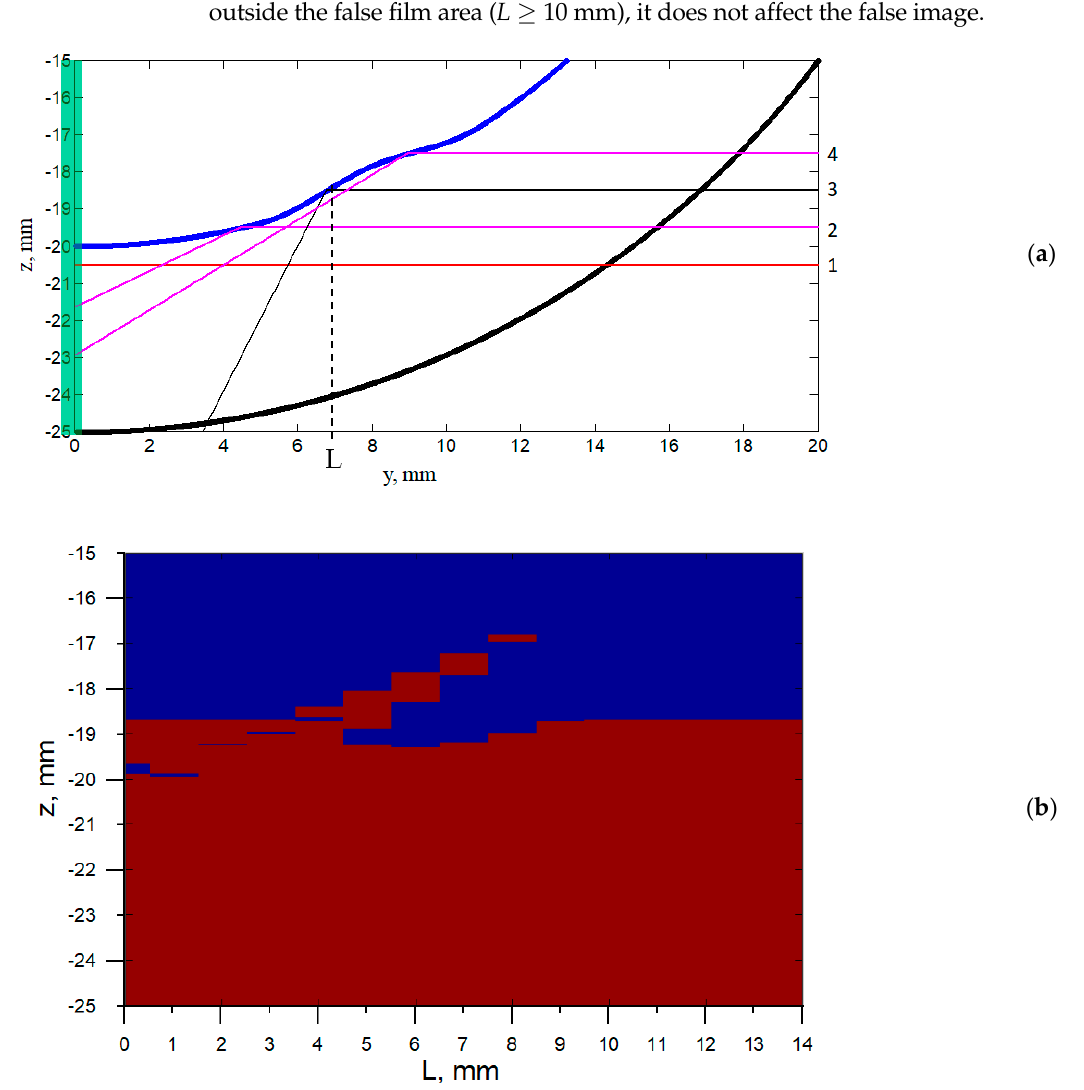
Figure 11. ( a ) The shape of annular liquid film with a small circumferential perturbation and the rays’ reflection at different heights. ( b ) Modeled PLIF-image for different y -positions of the perturbation. The calculations are made within the present review, as a development of the analysis first presented in [53].